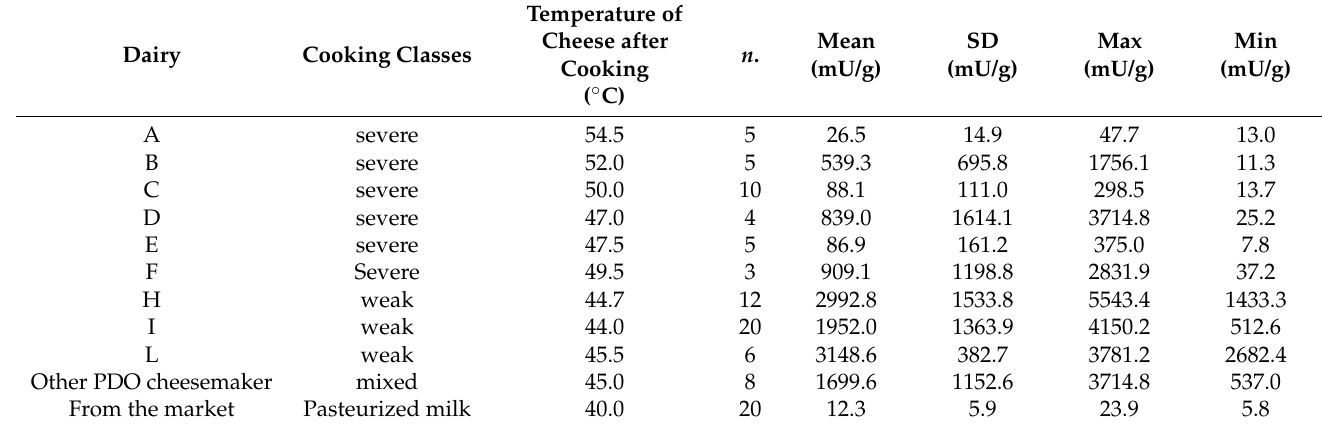
Table 3. ALP values in dairies belonging to the PDO Protection